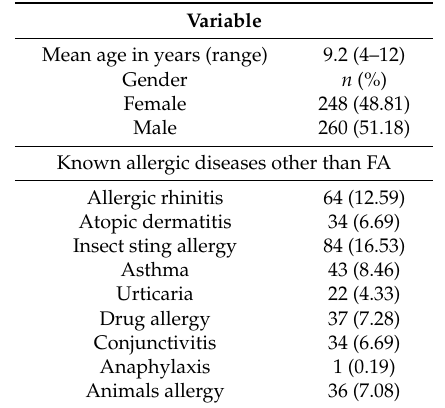
Table 2. Demographic and clinical characteristics of the study